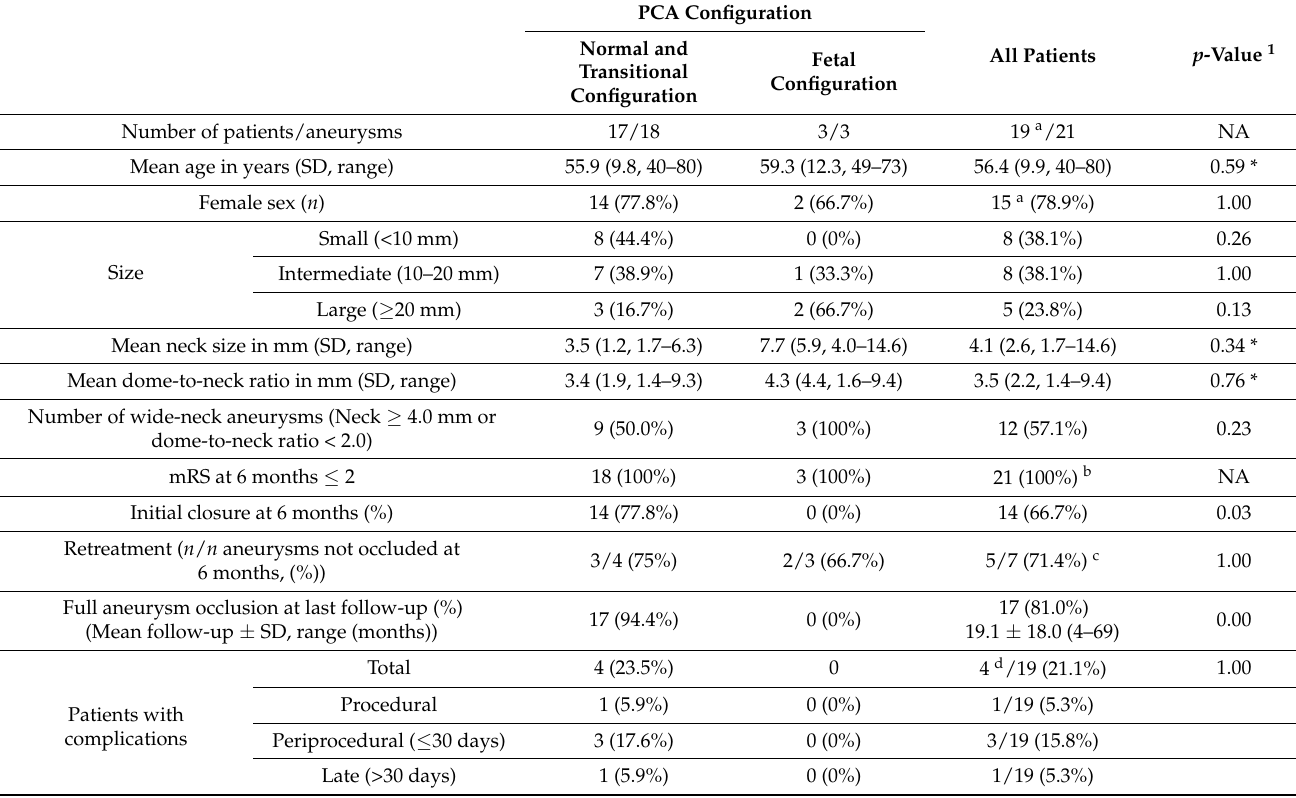
Table 1. Baseline characteristics and